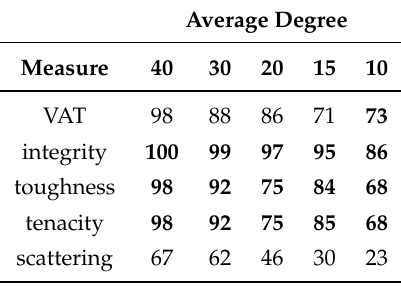
Percent accuracy for attributed networks with communities. Bold text indicates one-step clustering.